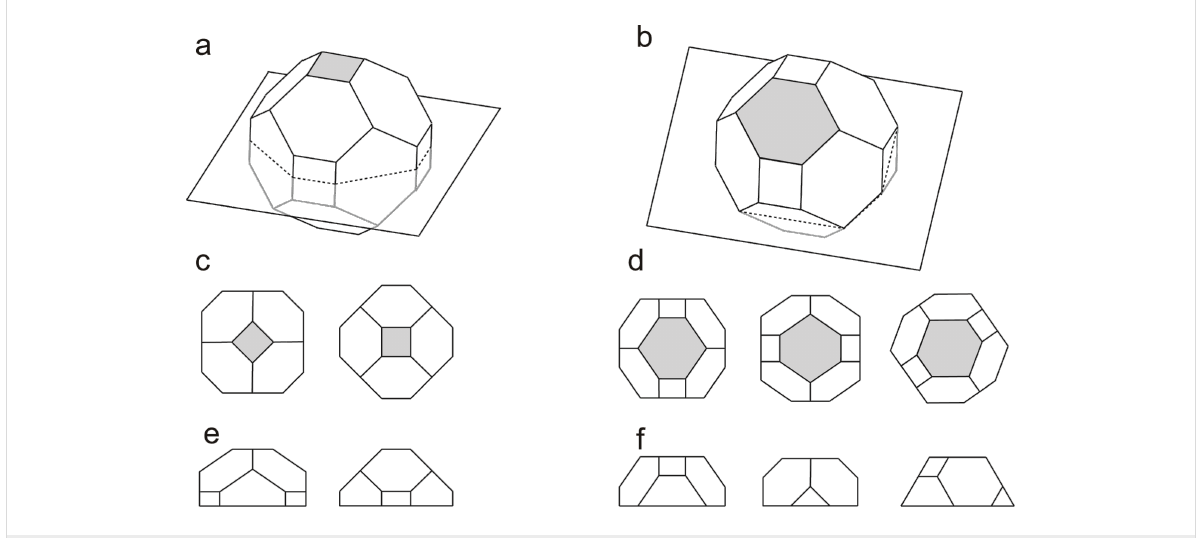
Figure 2: Schematic models of the nanoparticles with Wulff shapes. a) A truncated pyramid with OR1 and b) a distorted hexagon with OR2; c–f) corresponding top and side views. Top surfaces are shaded.